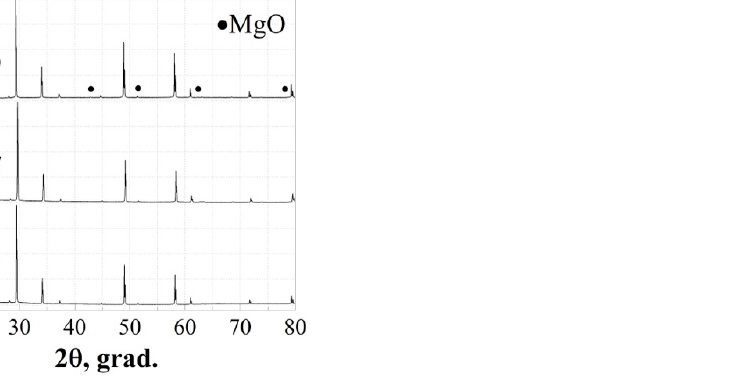
Figure 1. X-ray patterns obtained in air after annealing of the composites at 1500 °C: (1- x ) Gd 2 Zr 2 O 7 · x MgO. The black dots denote the MgO phase reflections.